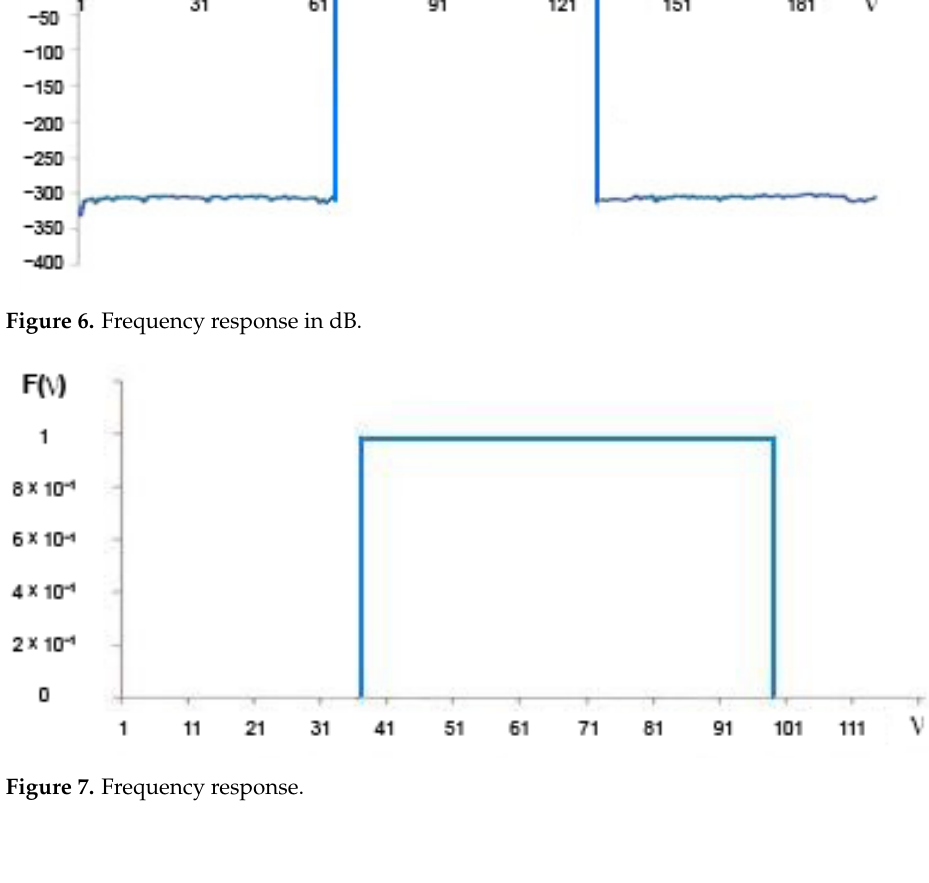
Figure 8. Frequency response in dB. The parameters of the impulse response of the filter are determined as follows: 𝑏 (cid:3015)(cid:2878)(cid:3038) =